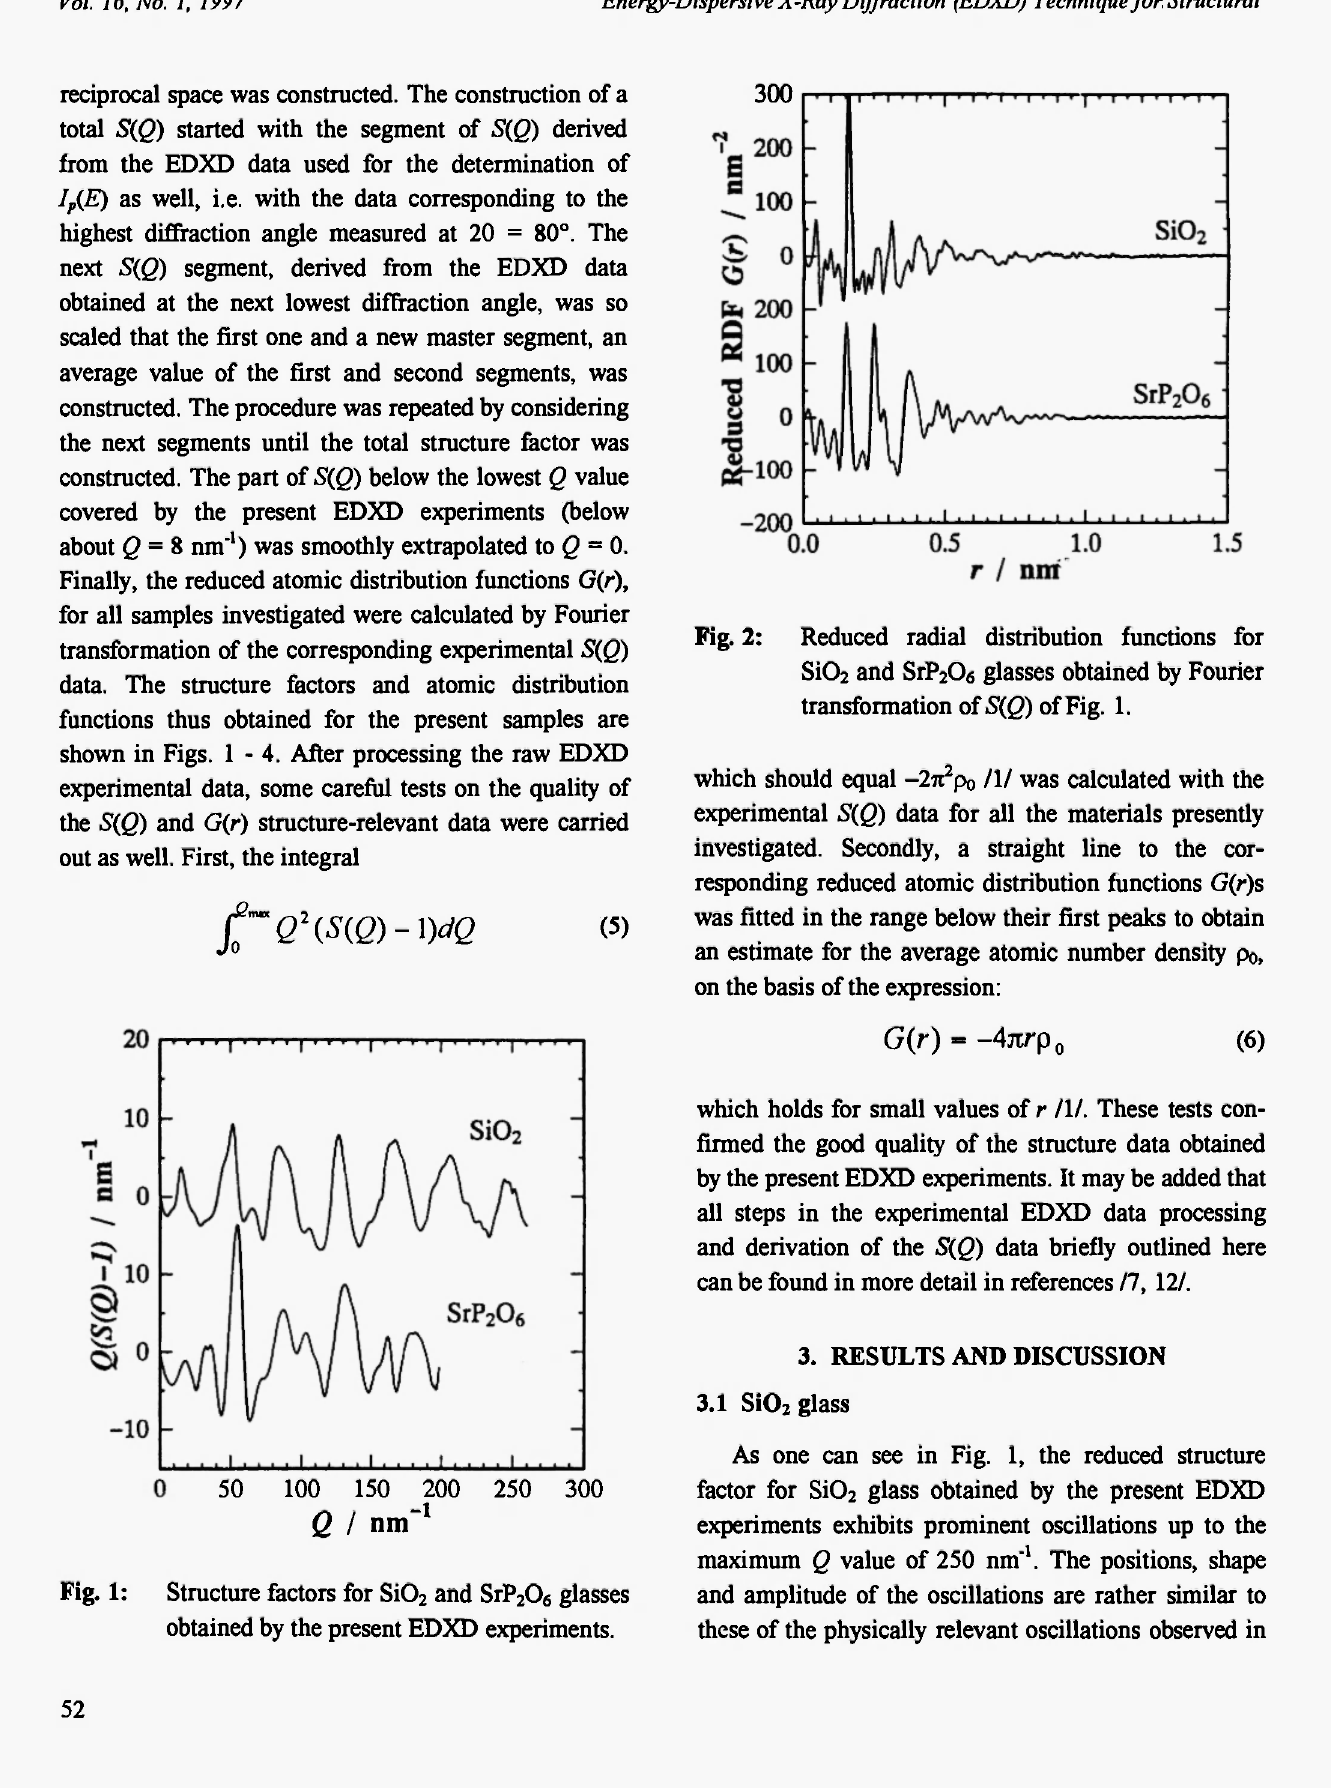
and SrP 0 glasses 2 2 6